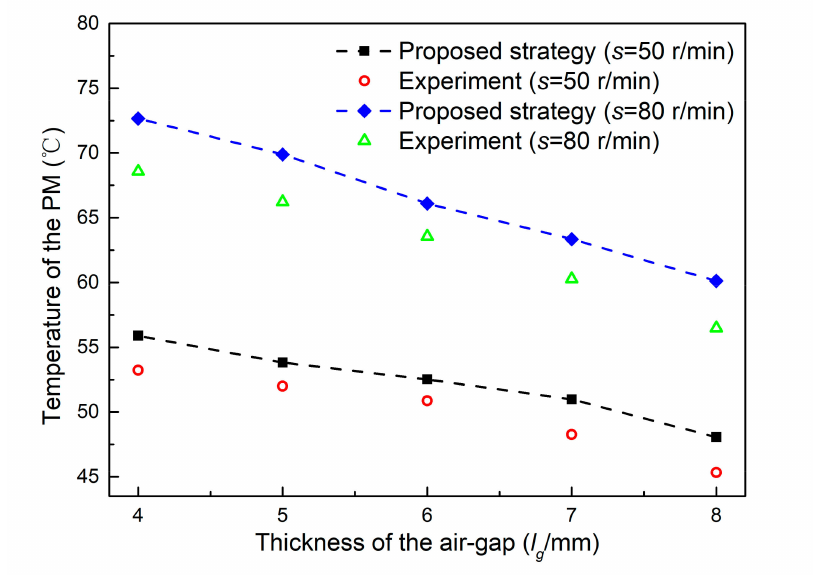
Figure 18. Comparison between proposed strategy and experiment under di ff erent air-gaps and slip